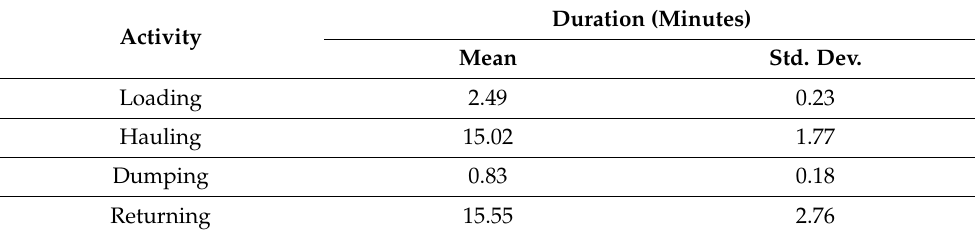
Figure 12. Distribution of loading time. Table 3. The mean and standard deviation of each